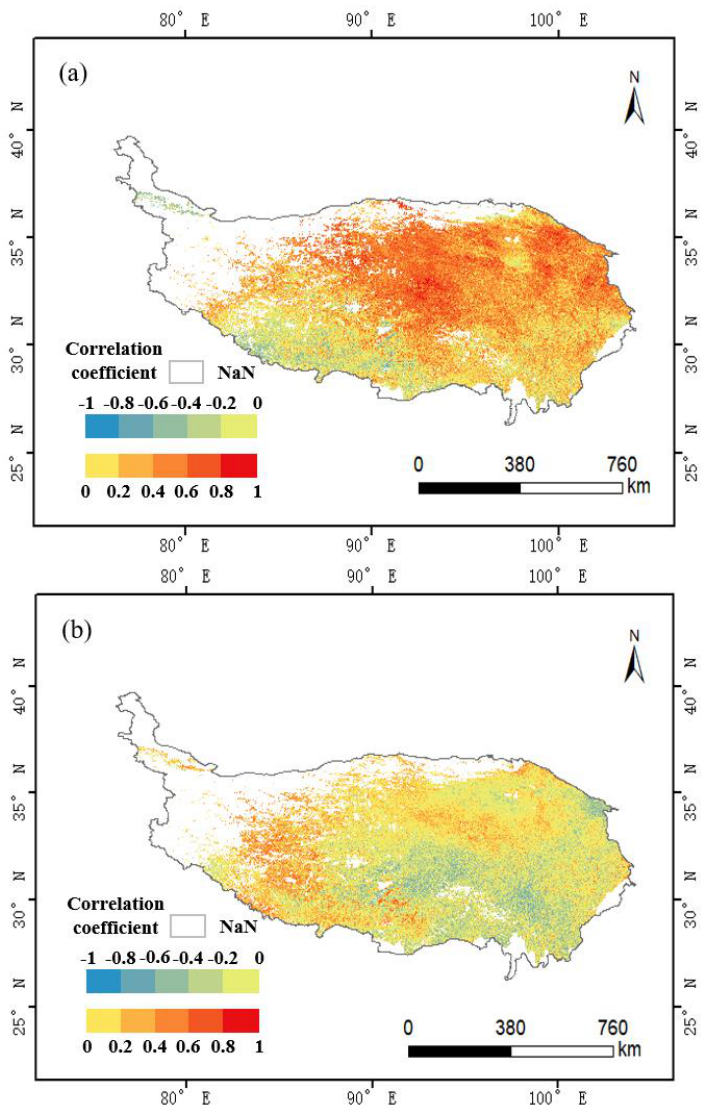
Figure 8. Correlation analysis of vegetation NPP with temperature ( a ) and precipitation ( b ) in QTP during 2001–2017. NaN represents no change in NPP or climate data for the region from 2001 to 2017 (the denominator in the correlation coefficient equation (Equation (2) in Section 2.2.2) was zero).